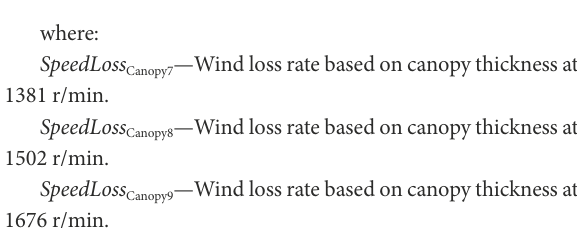
TABLE 3 R 2 values of the regression models under different spray fan speeds.